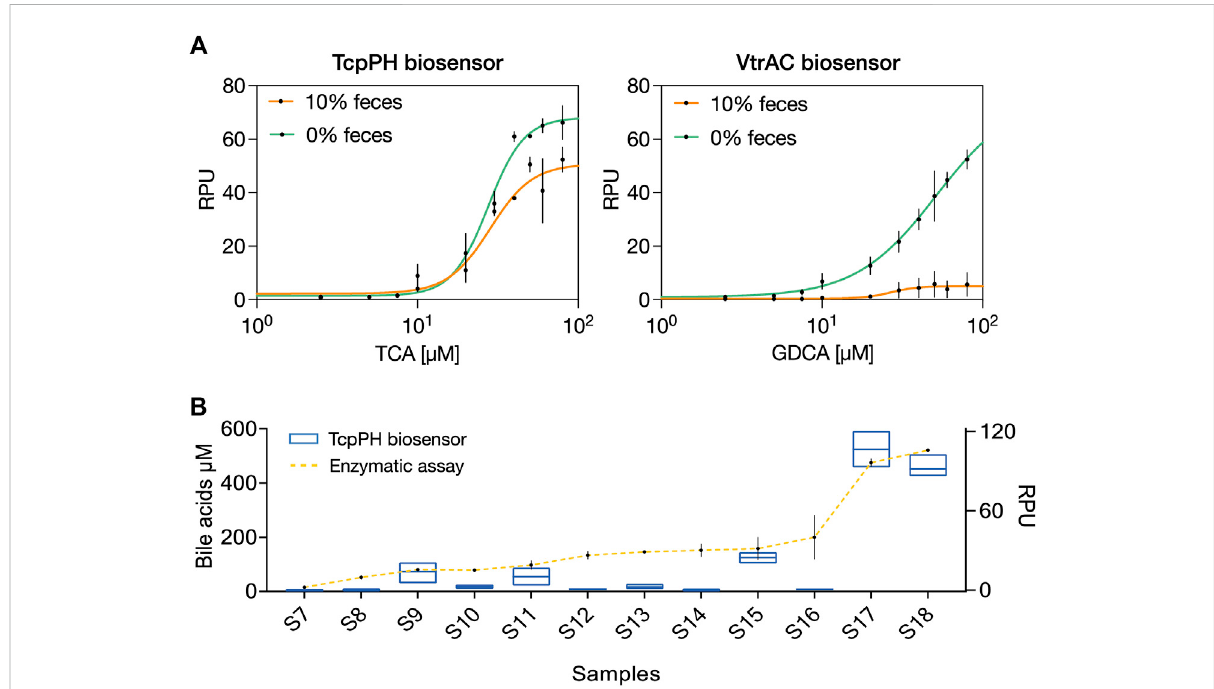
FIGURE 3 Bile acids detection in fecal solution from IBD patients. (A) The response function of TcpP/TcpH biosensor (left) and VtrA/VtrC biosensor (right) to spiked taurocholic acid (TCA) and glycodeoxycholic acid (GDCA) in the presence of 10-fold diluted feces (three different samples were pooled; samples S5, S6 and S7, see Supplementary Table S2). Data points correspond to the mean value of four replicates on four different days. Error bars: ±SD. (B) Comparison of total bile acid detection between TcpP/TcpH (blue square) biosensor, right axis, and enzymatic assay (yellow line)